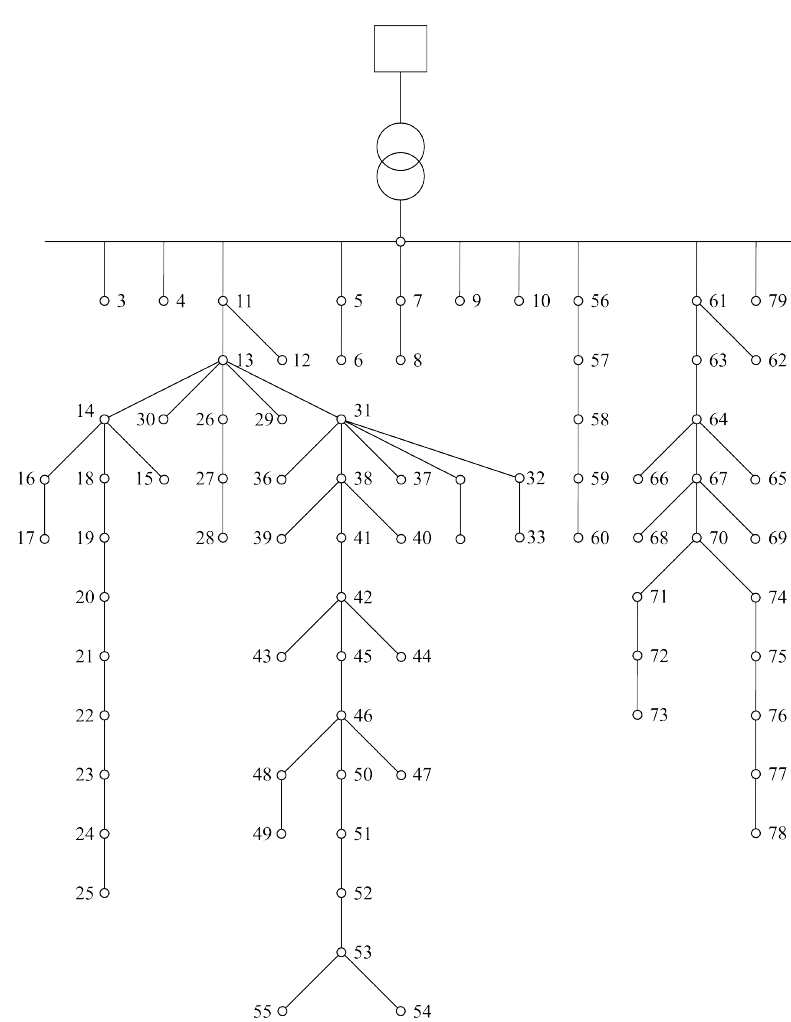
Figure 3. Feeder topology used to assess the performance the examined control strategies.